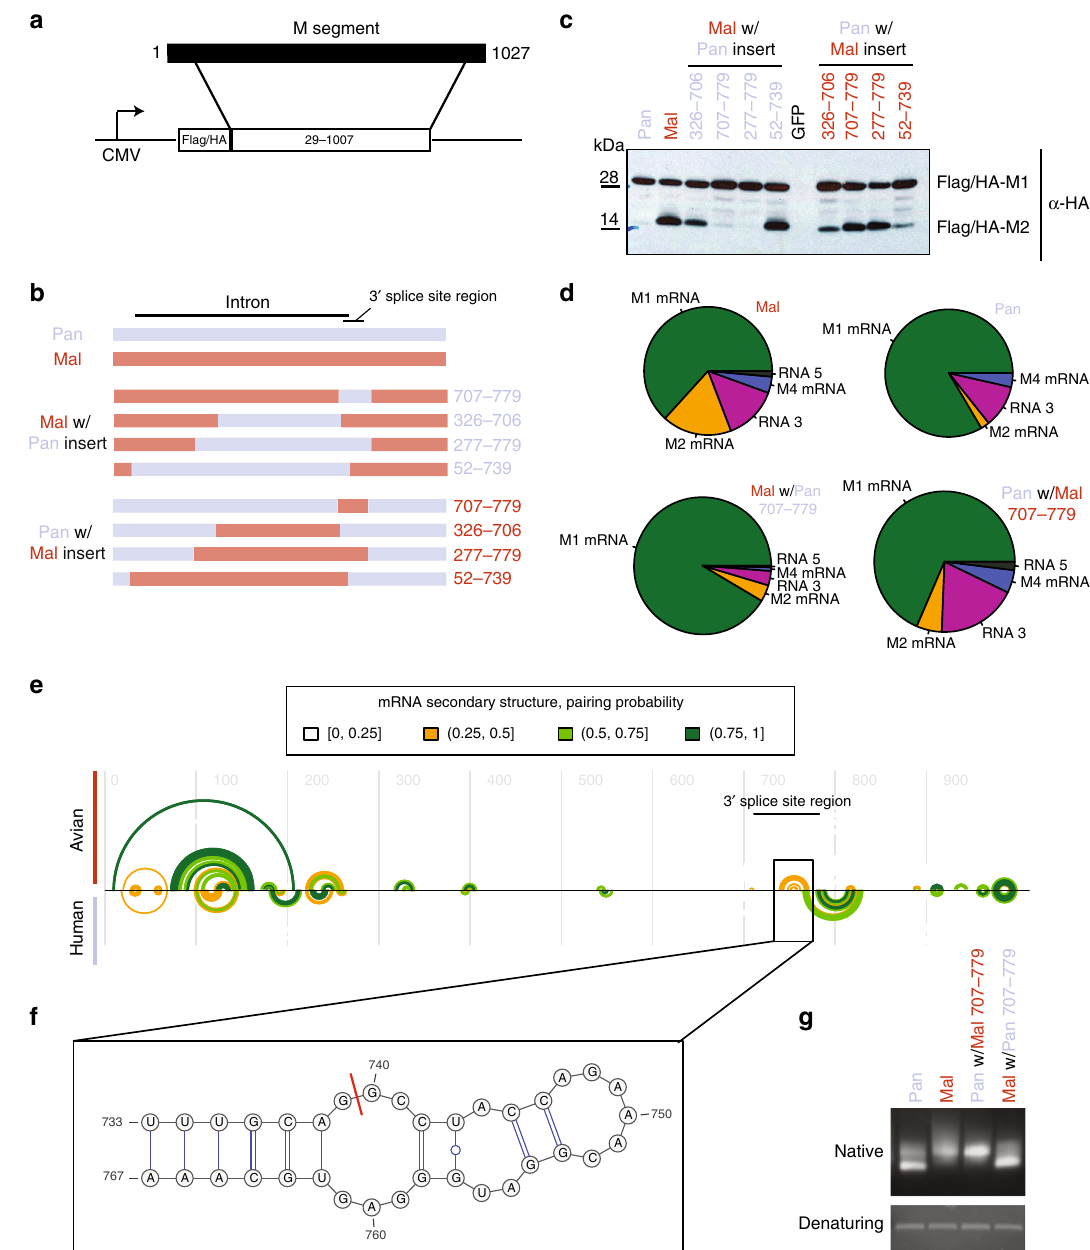
Fig. 5 A cis -regulatory element in the 3 ′ splice site region controls M segment splicing. a Reporter system. The coding sequence of segment 7 was cloned into a eukaryotic expression vector with N-terminal Flag/HA tag. b Wild-type Pan and Mal sequences as well as several chimeric Pan/Mal constructs were cloned into the reporter vector. c A549 cells were transfected with the indicated reporter constructs, harvested, and subjected to anti-HA immunoblotting. d HEK293T cells were transfected with constructs encoding NP, PA, PB1, and PB2 (of strain WSN) and vectors encoding for wild-type or chimeric M segments. At 24h post transfection, RNA was isolated and subjected to RNA-seq. The pies depict the relative counts of isoforms as quanti fi ed by splice junction reads normalized to the levels of NP and polymerase subunits. The area of the pies scales with the total number of normalized splice junction reads. The average of n = 2 biological replicates is depicted. e Evolutionary conserved RNA secondary structure along the M mRNA predicted for avian-adapted (top) and human-adapted H3N2 (bottom) IAV strains. Each semi-circle corresponds to 1 bp involving the corresponding two alignment positions. Color coding of base pairs according to their corresponding, estimated base-pairing probability. The 3 ′ splice site region (nt 707 – 779) is annotated with a bar. f The insert shows a detail of the predicted RNA secondary structure at the 3 ′ splice site, predicted for avian but not human sequences in this study. The splice position is indicated by a red bar. g The region predicted to be structured with the two species-speci fi c and mutually exclusive elements (707 – 825) was in vitro transcribed. The RNA was puri fi ed and run on native and denaturing agarose gels stained with ethidium (see Methods). This program is capable of dis-entangling over- coding regions, for example, in viral genomes such as hepatitis C lapping evolutionary constraints due to encoded amino acids and RNA structure features and has been shown to successfully identify